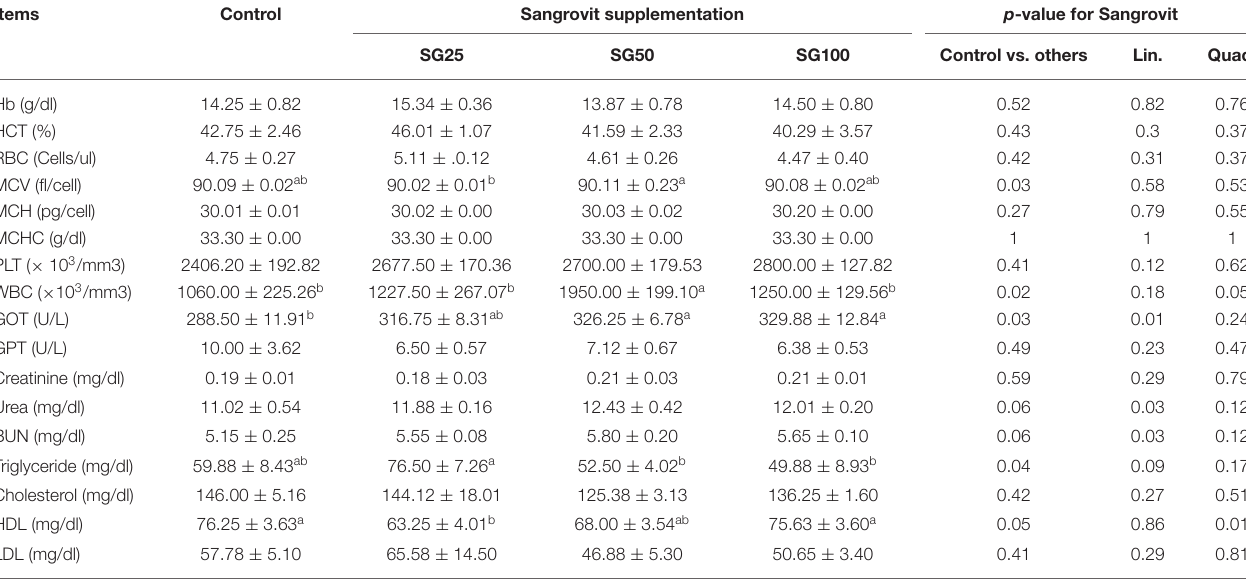
TABLE 5 | Effect of Macleaya cordata dietary supplementation on hematological and biochemical parameters of turkey at the 20 th week of age.